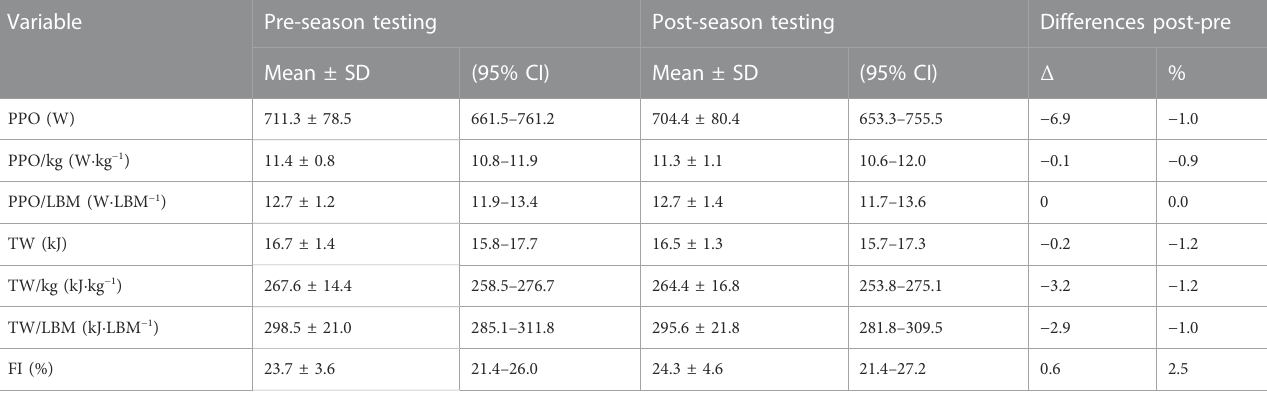
TABLE 3 Pre- and post-season testing mean ± standard deviation and 95% CI of anaerobic performance determined in the Wingate test.